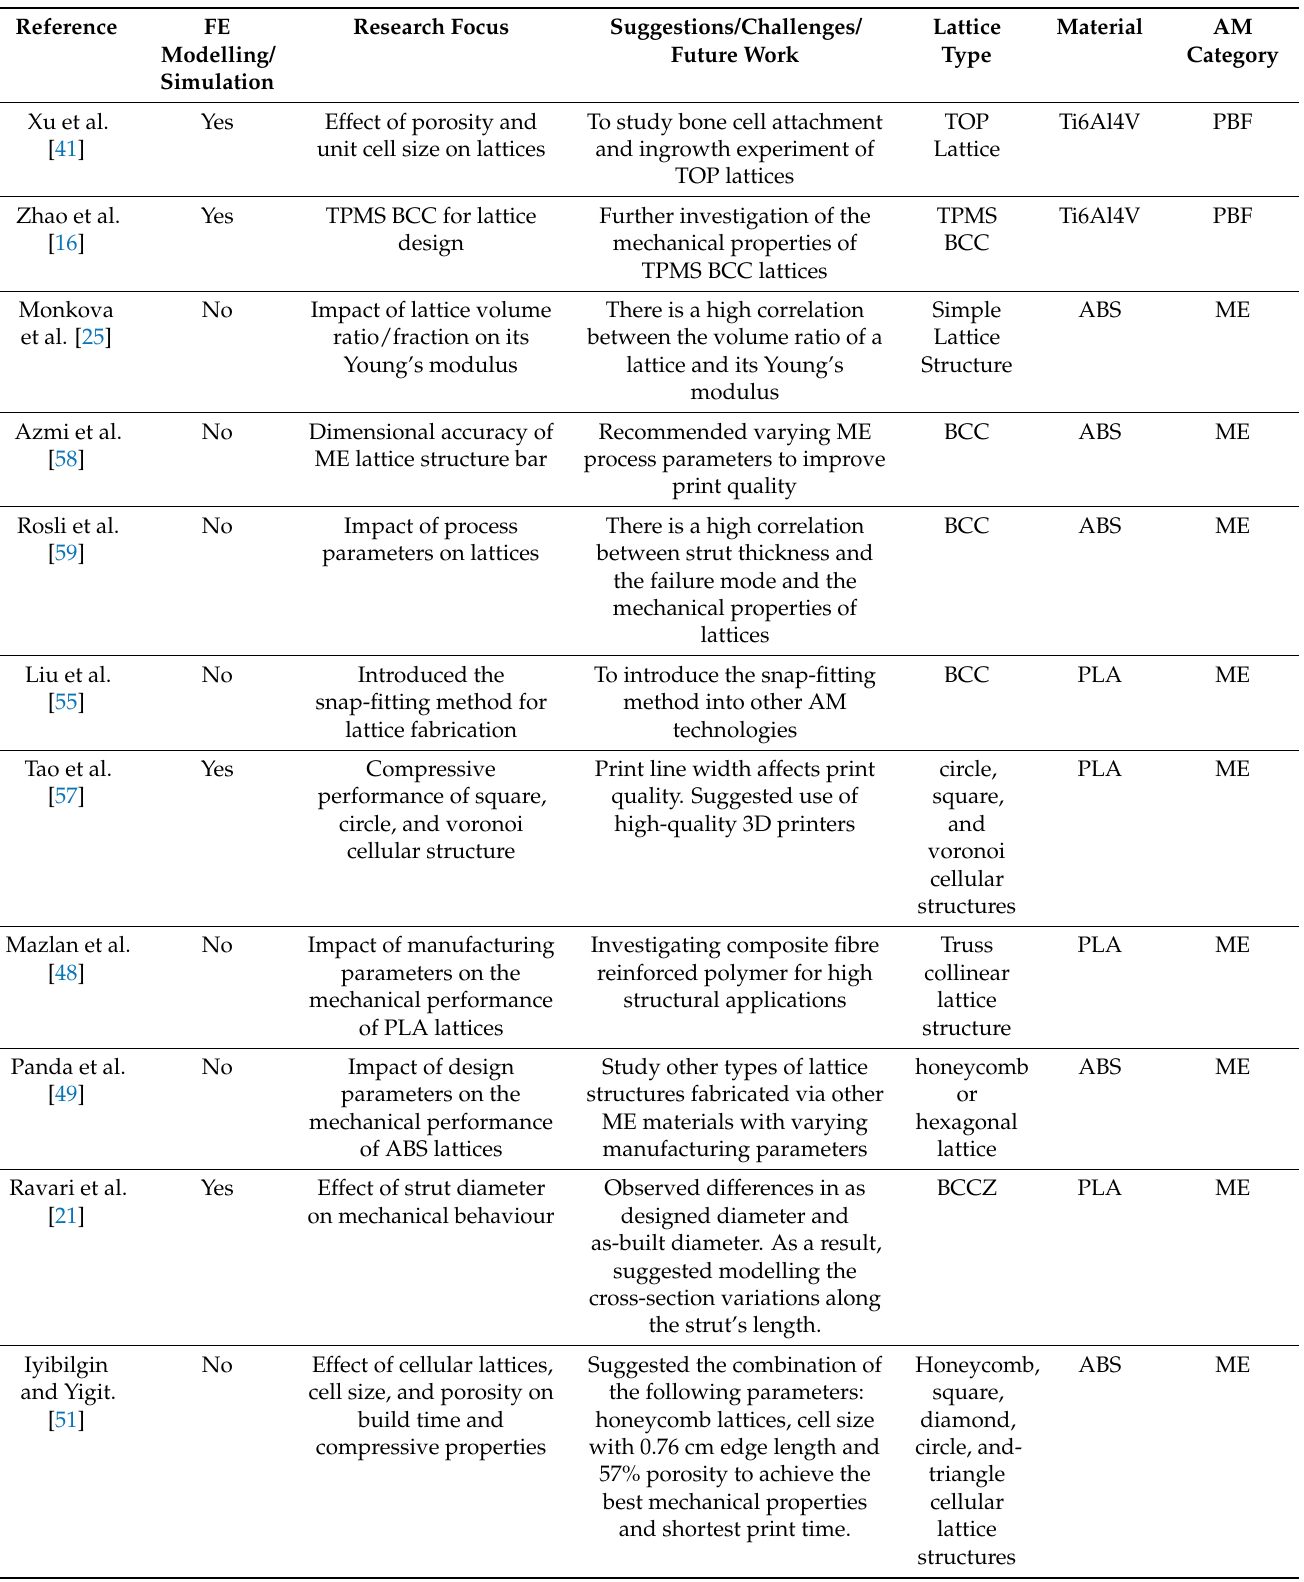
Table 3. Summary of challenges, general recommendations, and suggestions arising from the reviewed